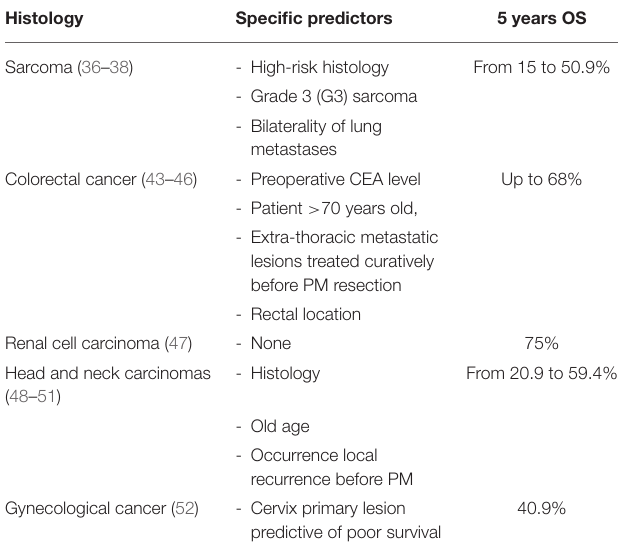
TABLE 2 | Specific predictors and reported 5 years OS survival according to different histological type.